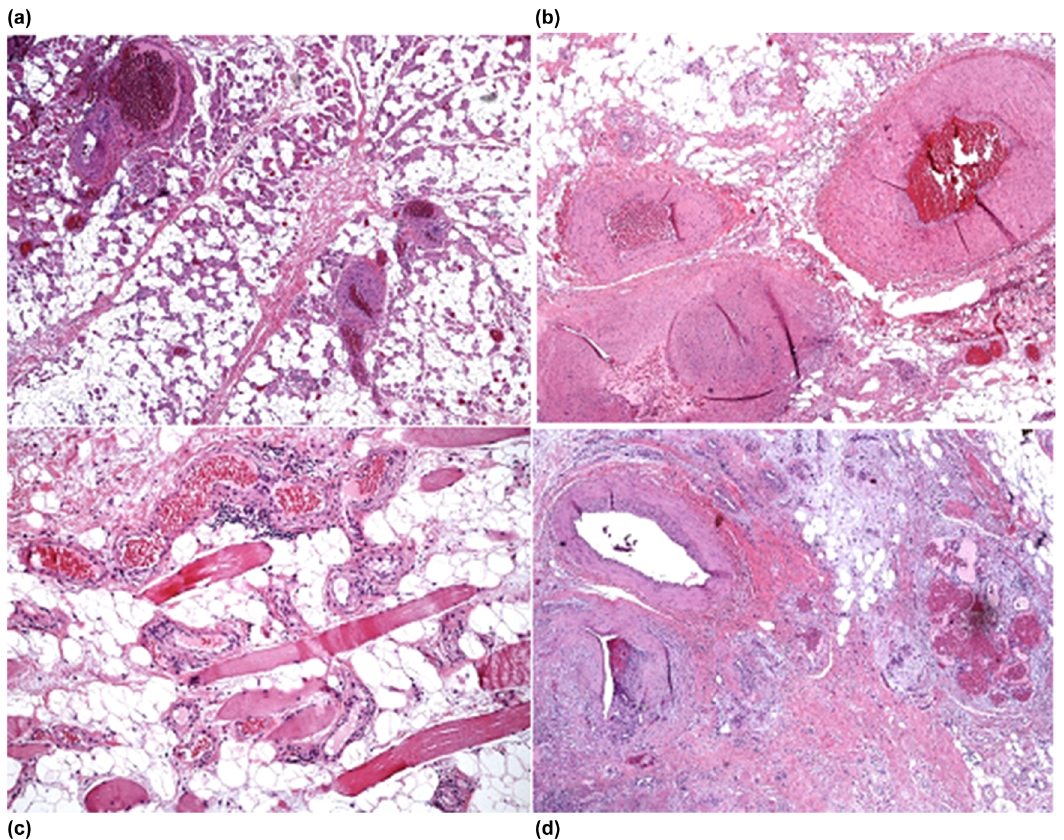
Figure 4: Histological analyses of the resected tissues. ( a ) Fibrous tissue; ( b ) clusters of thin - walled venous channels; ( c ) adipose tissue; ( d ) lymphoid aggregates within the skeletal muscle. Magni fi cation: 40 × ; stain: hematoxylin and